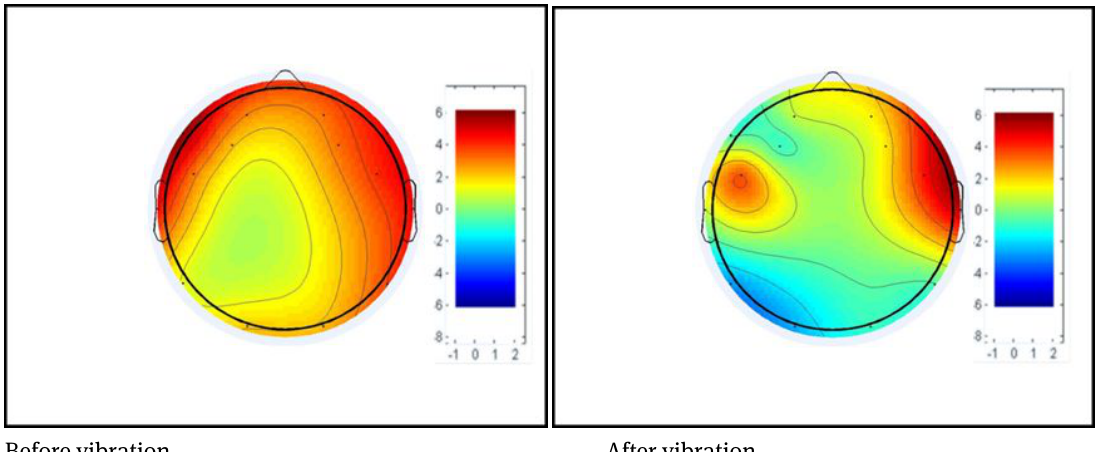
Before vibration After vibration Fig. 9. Figure shows scalp topography images of beta activity before and after vibration. Reduction in wakefulness is indicated by the changes of shaded area on frontal